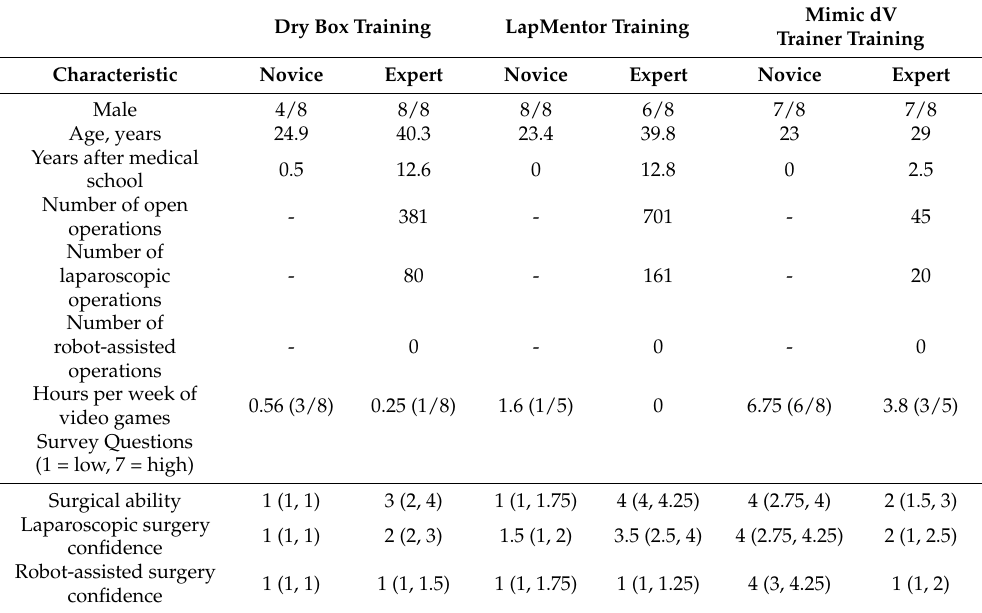
Table 1. Participant characteristics before training (Self-Assessment 1).